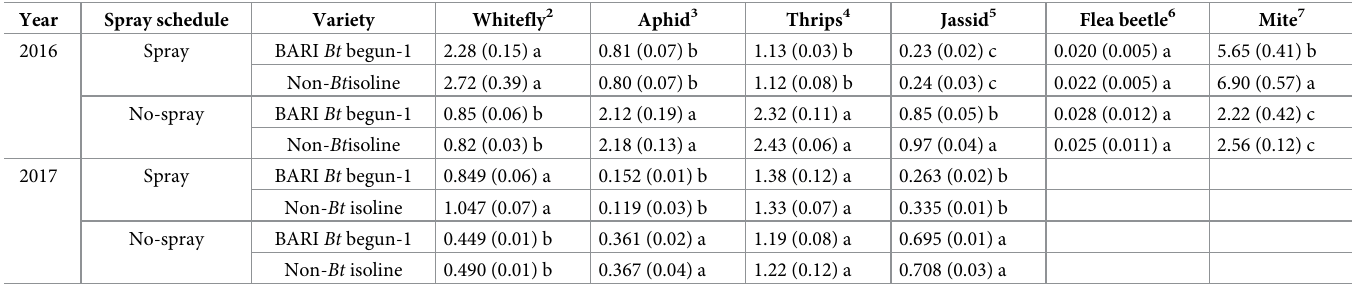
Table 8. Mean abundance 1 of non-target pest arthropods (No./leaf) in brinjal relative to insecticides and varieties, OFRD, BARI, Bogra,